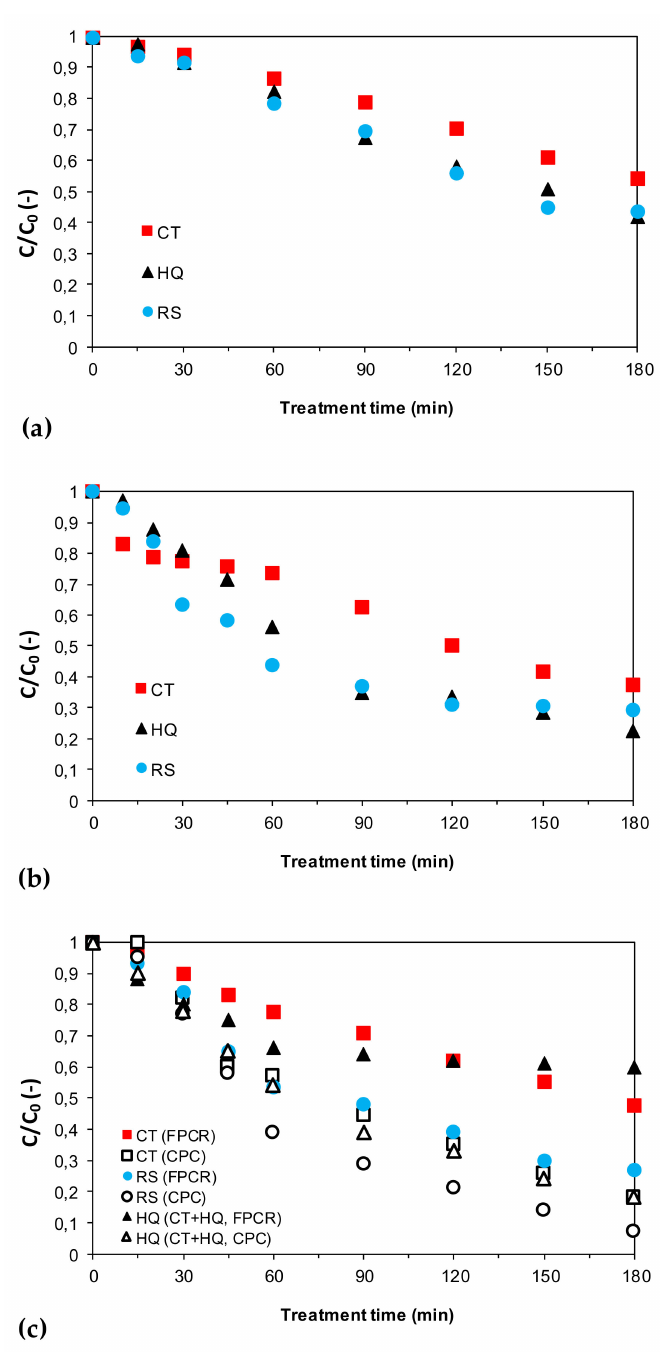
Figure 3. Normalized concentration profiles of dihydroxybenzenes during photocatalytic experiments using TiO 2 -GF: ( a ) degradation of CT, HQ and RS in single pollutant model solutions in FPCR at given experimental conditions; ( b ) degradation of CT, HQ and RS in single pollutant model solutions in CPC at given experimental conditions; ( c ) degradation of CT (red and white squares) and RS (blue and white circles in CT + RS binary mixture in FPCR and CPC and degradation of HQ (triangles) in CT + HQ binary mixture in FPCRC and CPC at given experimental